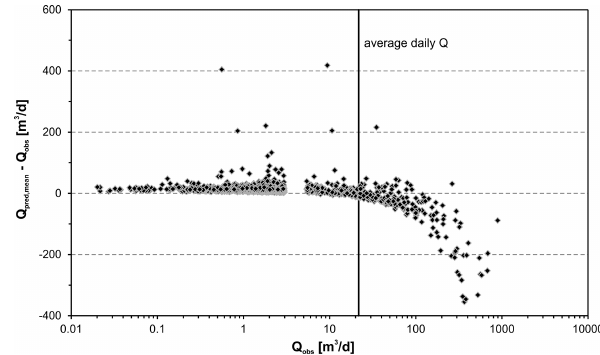
Figure 12. Deviation of the predicted ensemble means Q pred , mean of daily discharge from the observed discharge Q obs . To plot the log Q obs we added 5 × 10 − 5 m 3 d − 1 to the average daily